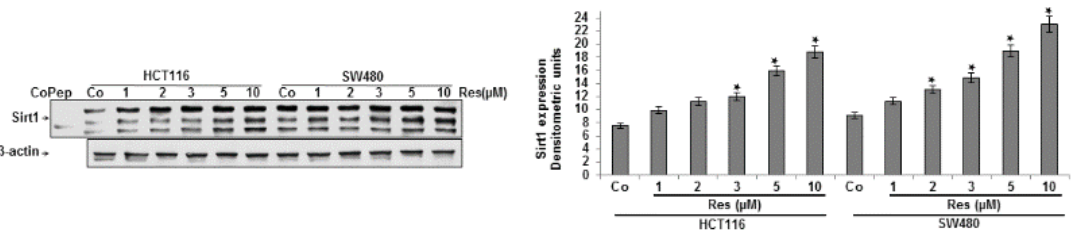
Figure 1. The effects of resveratrol on Sirt1 expression in CRC cells in the alginate tumor microenvironment. Serum ‐ starved HCT116 and SW480 cell lines in alginate culture (1 × 10 6 /mL) were either left untreated or treated with different concentrations of resveratrol alone (1, 2, 3, 5, 10 μ M) for 14 days. Whole cell lysates were prepared and analyzed by Western blotting with antibodies against Sirt1. Sirt1 control peptide (Co Pep) was used as a control for Sirt1 antibody specificity. The results shown are representative of three independent experiments. Housekeeping protein β‐ actin served as a loading control in all experiments. Densitometric evaluation of protein expression as revealed by statistically ‐ significant values with p < 0.05. Significant values are marked with an asterisk